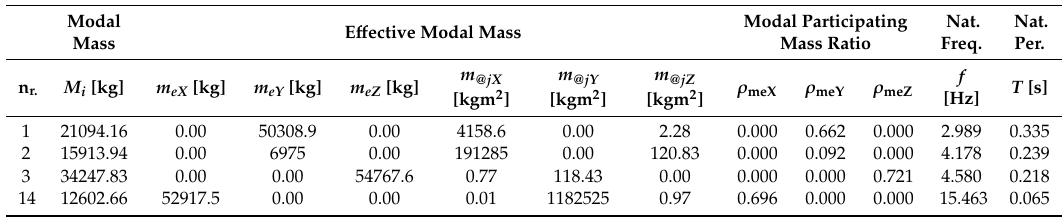
Table 2. Results of the modal analysis of the original model ( m eX , m eY , m eZ : translational masses; m @jX ,